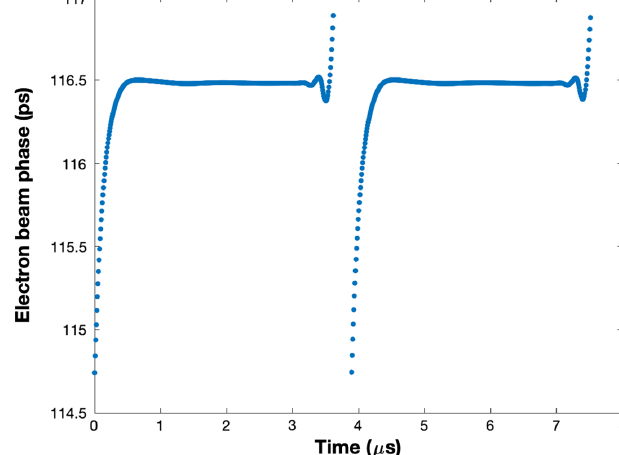
FIG. 4. IP time offset with direct loop feedback.